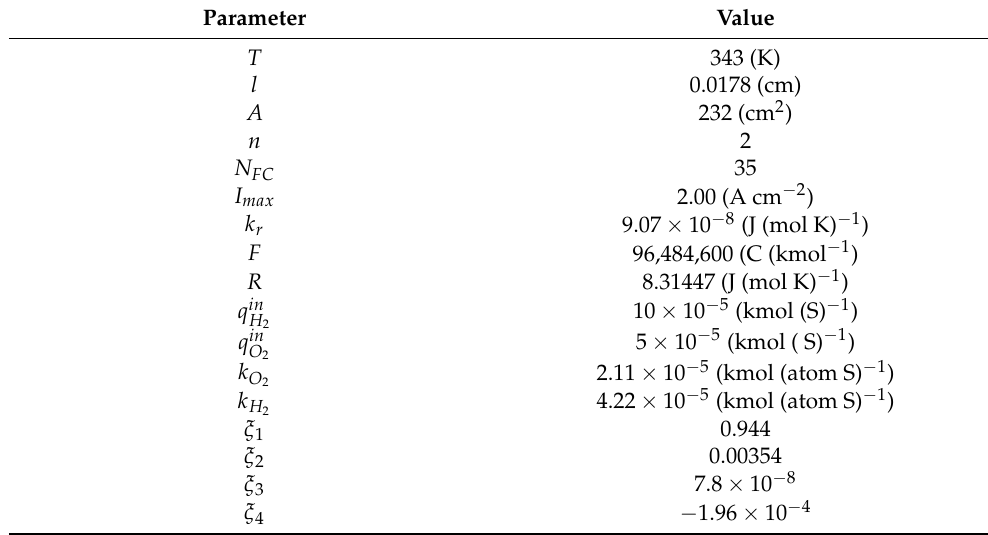
Table 2. The specifications and parameters of PEMFC in the studied system. Parameter